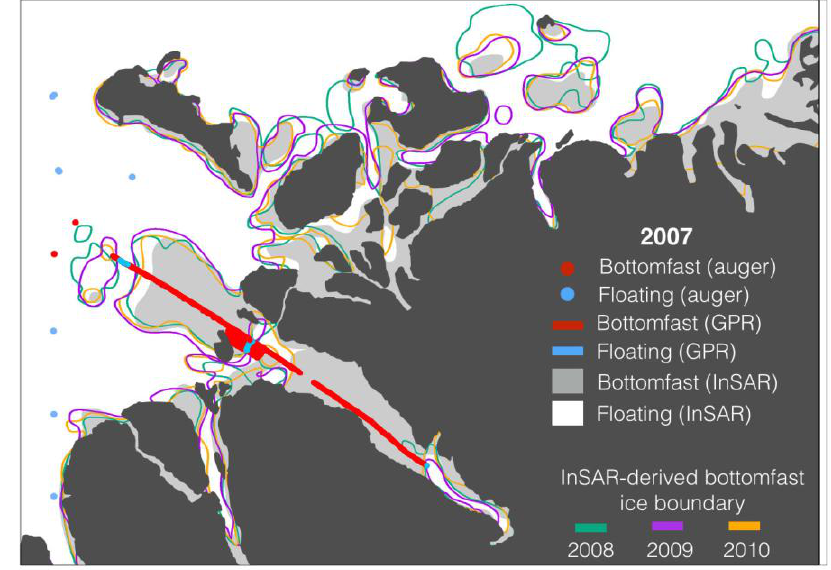
Figure 4. Bottomfast ice near Kendall Island, Mackenzie Delta, Canada spring 2007 delineated from an ALOS PALSAR interferogram from 3 January to 18 February (light gray). Auger validation points were acquired 19 March–2 April and GPR data on 28–29 March. In addition, InSAR-derived bottomfast ice is delineated for proceeding years using acquisitions from 6 January and 21 February 2008 (green), 8 January and 23 February 2009 (purple), and 11 January and 26 February 2010 (yellow).